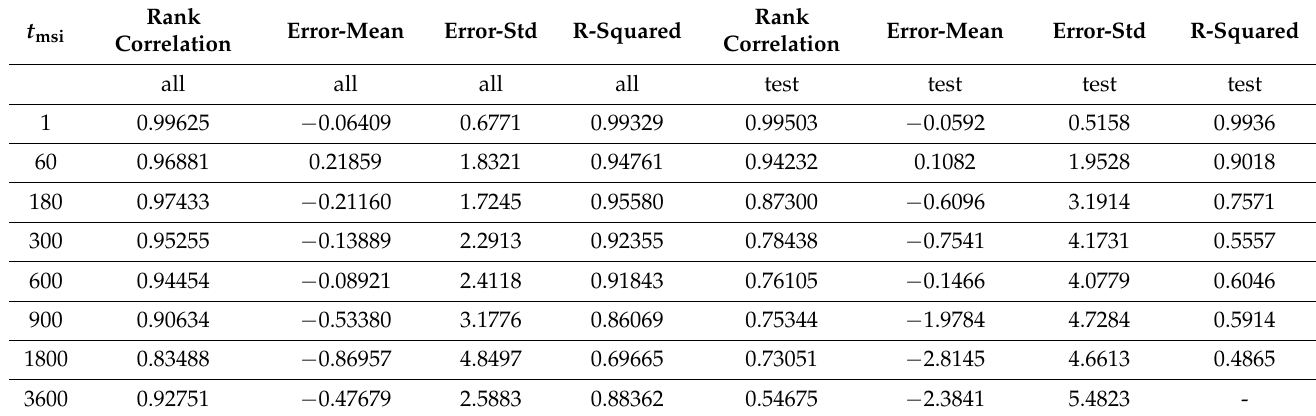
Table 2. Comparison of calculated error metrics between test and all data for various multistep time intervals.